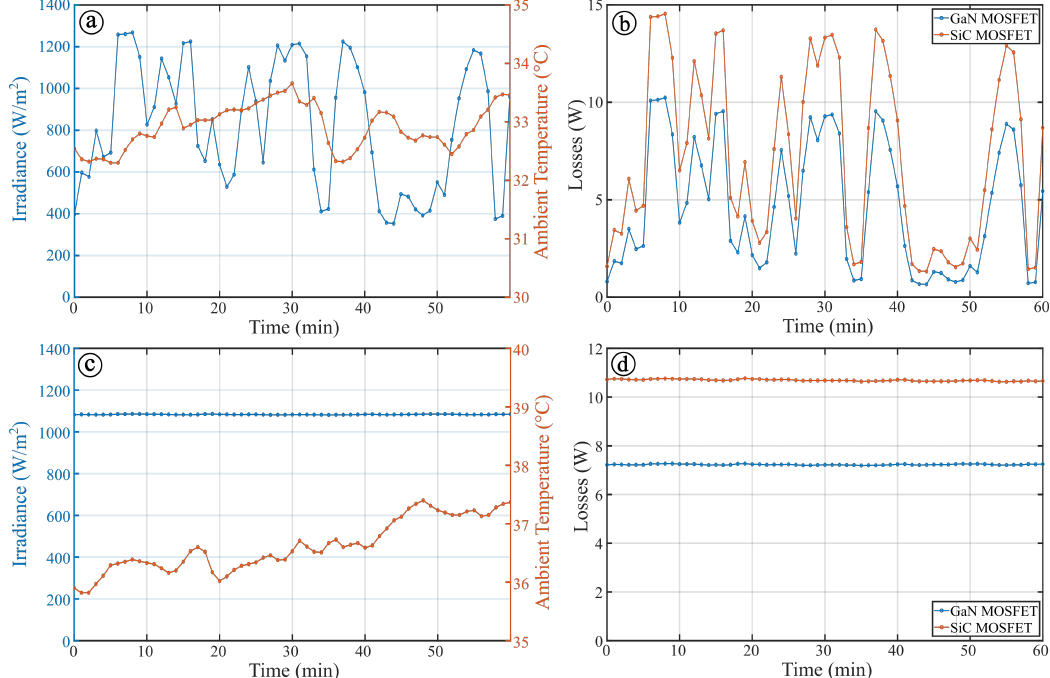
Figure 11. Translating a ( a , b ) one-hour cloudy mission profile and ( c , d ) a one-hour clear mission profile of Arizona into the corresponding junction losses profile of the used